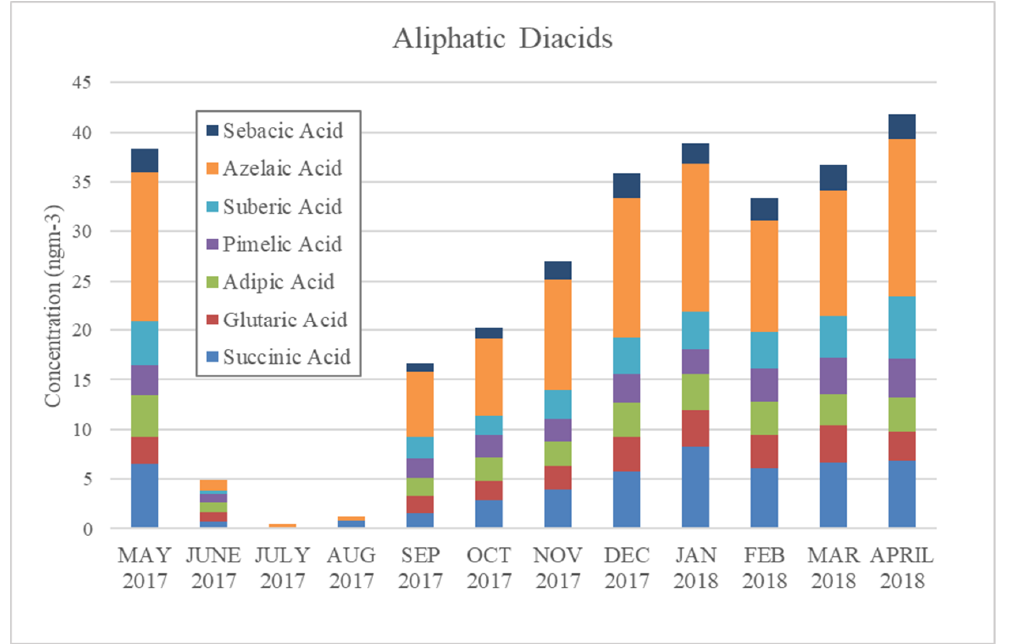
Figure 5. Monthly concentrations of aliphatic diacids in Yangon,